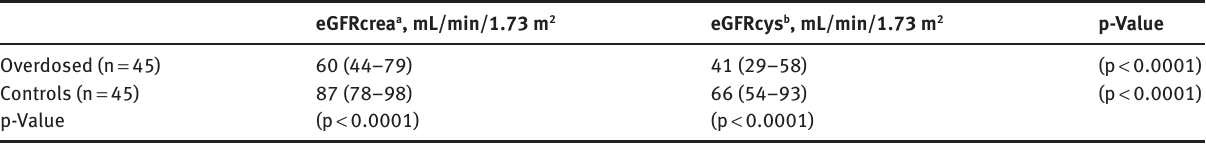
Table 2: The medians (IQR) of the eGFRcrea and eGFRcys in overdosed patients and controls. eGFRcrea a , mL/min/1.73 m 2 eGFRcys b , mL/min/1.73 m 2